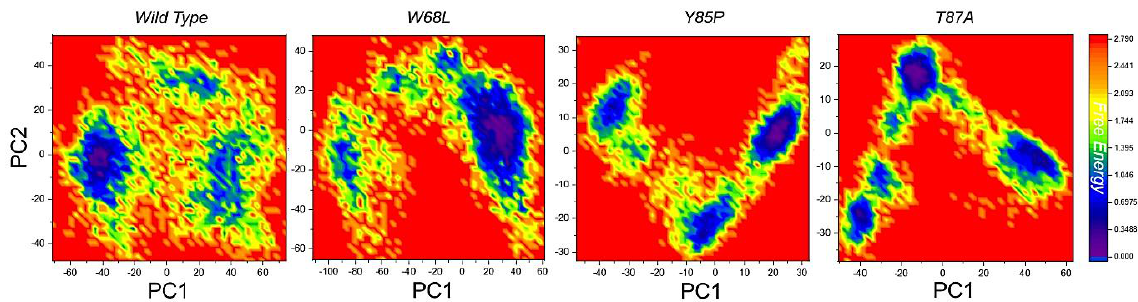
Figure 8. Free energy landscape (FEL) of all the complexes, i.e., wild type, W68L, L85P and T87A.